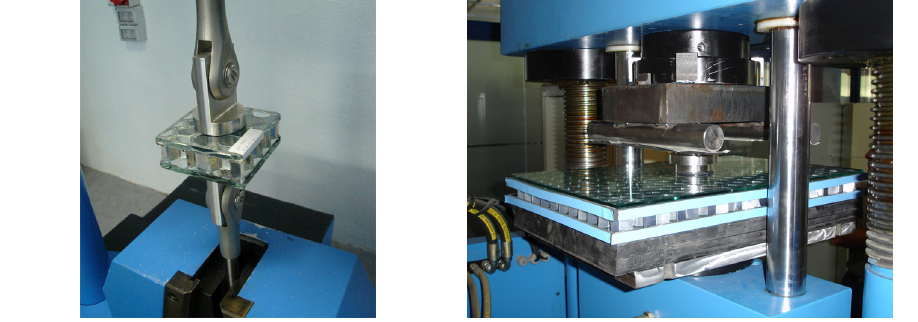
Figure 6: Tensile strength test. Figure 7: Punching strength test.